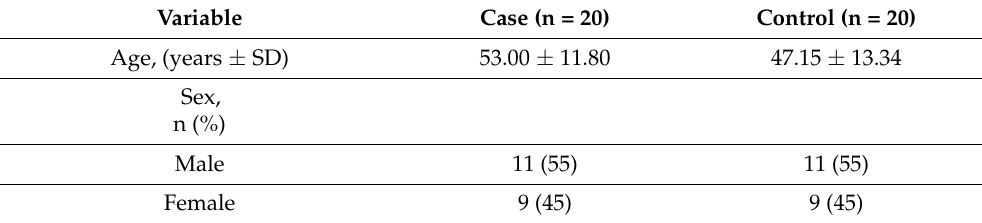
Table 1. Demographic characteristics of the subjects.